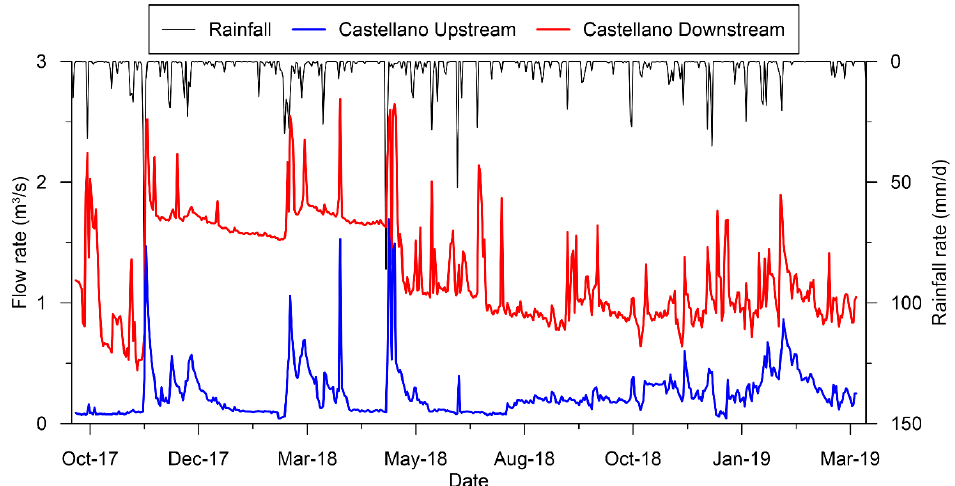
Figure 4. Continuous monitoring of the stream flow in the two instrumented sections of the Castellano stretch (upstream and downstream hydrographic stations in Figure 2 are represented with blue and red lines, respectively). Rainfall for the same period is also shown (black line).